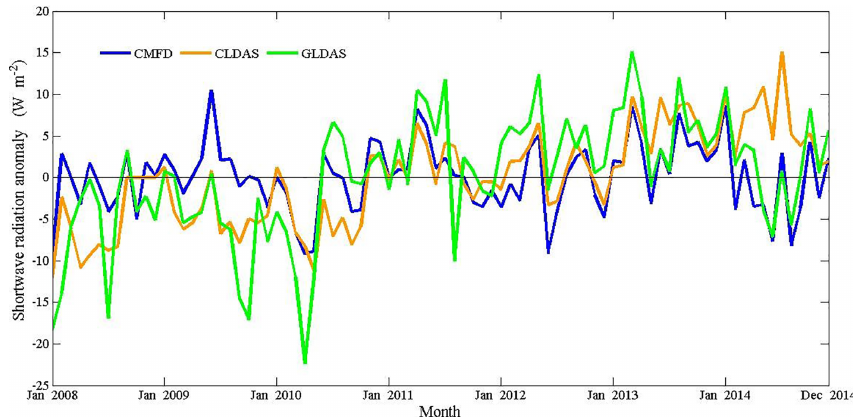
Figure 12. Time series of monthly mean shortwave radiation anomalies relative to the mean annual cycle from CMFD (blue), CLDAS (orange) and GLDAS (green; unit: Wm − 2 )